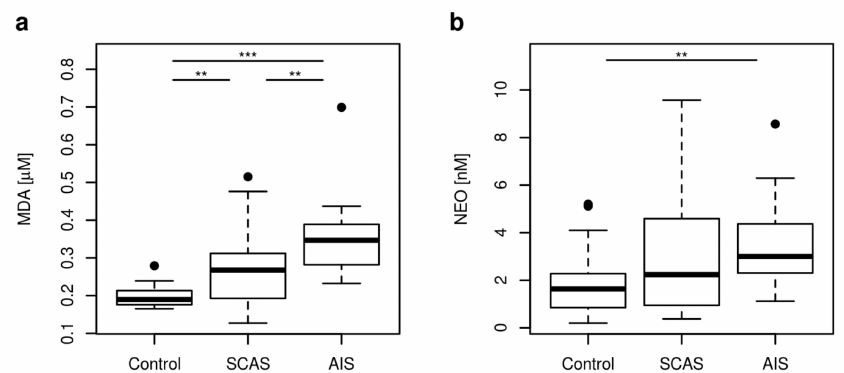
Figure 5. Plasma concentrations of MDA and NEO represented as boxplots. ( a ) MDA concentration was employed as a criterion of OS; ( b ) NEO concentration was employed as a marker of